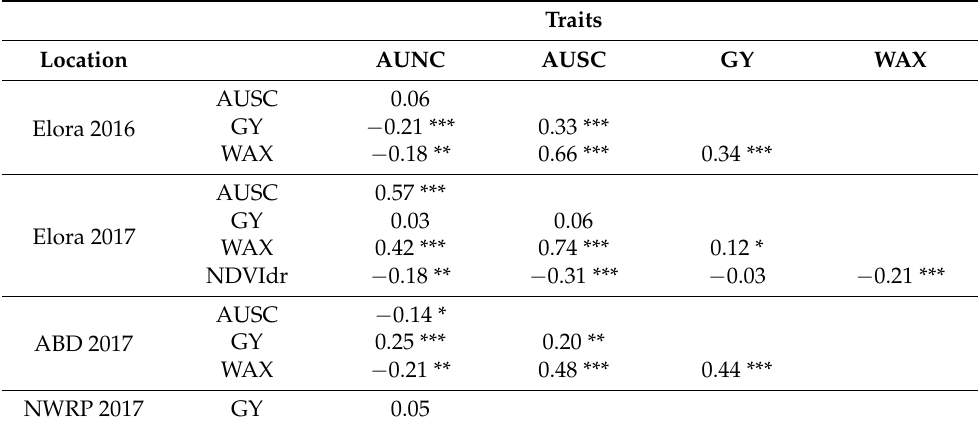
Table 1. Pearson correlation measurements for pairs of phenotypic traits evaluated in four field experiments conducted in 2016 and 2017.